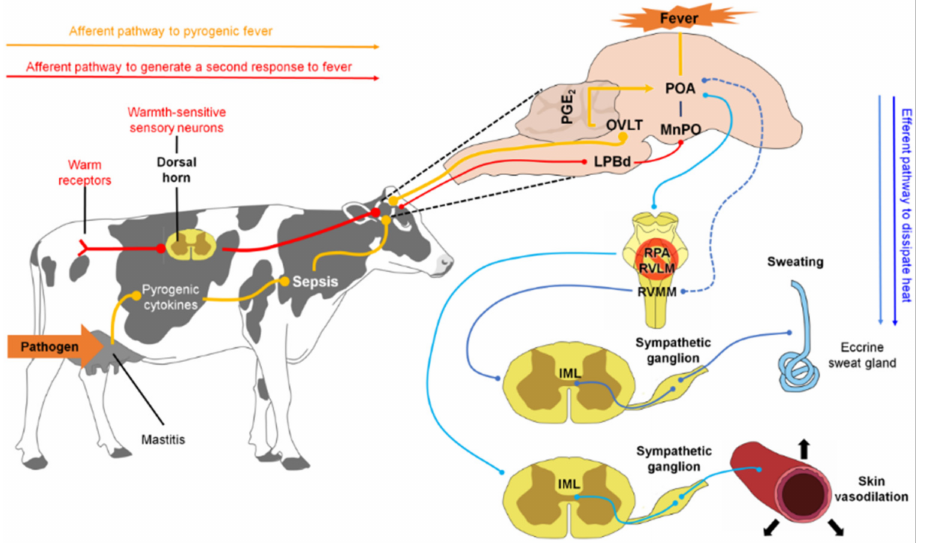
Figure 7. Neurophysiological mechanism of thermoregulation in a cow facing a febrile process. When a life-threatening temperature is reached, thermoreceptors transmit a nerve impulse that reaches the median preoptic nucleus. Once the POA is activated, responses are developed through efferent pathways to dissipate excess heat, such as sweating, which originates after transmitting a nerve impulse to the rostral ventromedial medulla (RVMM) through an unknown pathway (dashed line), and the IML to later reach the sympathetic fibers that innervate the eccrine sweat glands. Moreover, cutaneous vasodilation originates after the emission of an inhibitory impulse to the RPA and RVLM, structures involved in the vasoconstriction process, so that a signal is subsequently transmitted to the efferent sympathetic fibers innervating the peripheral blood